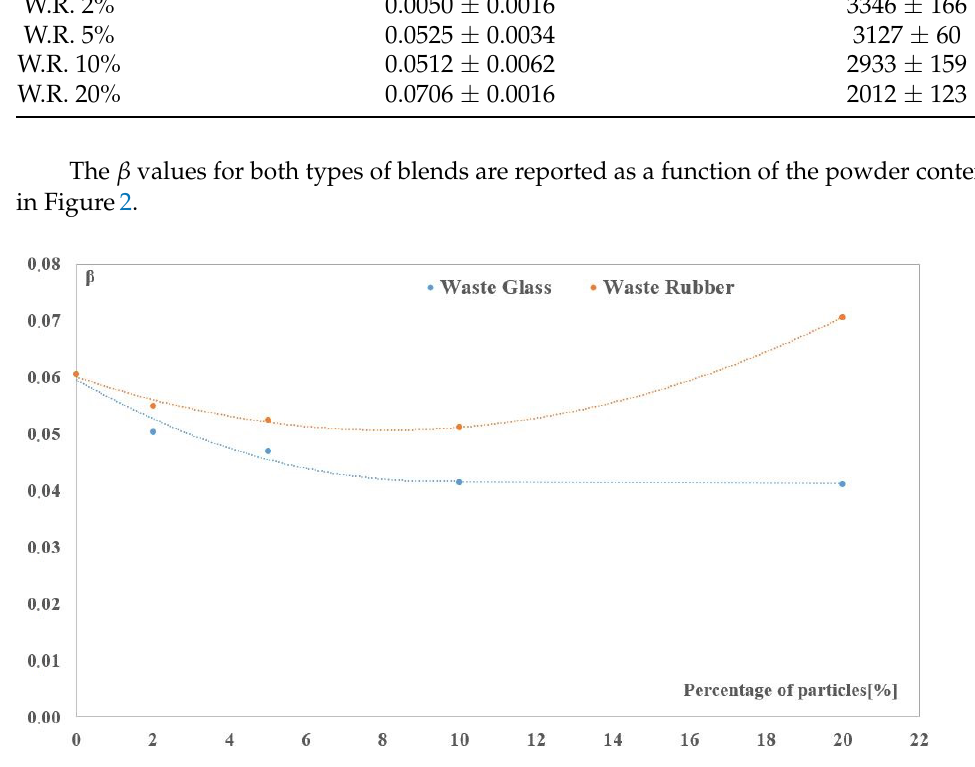
Figure 2. Trend of β in function of the particles